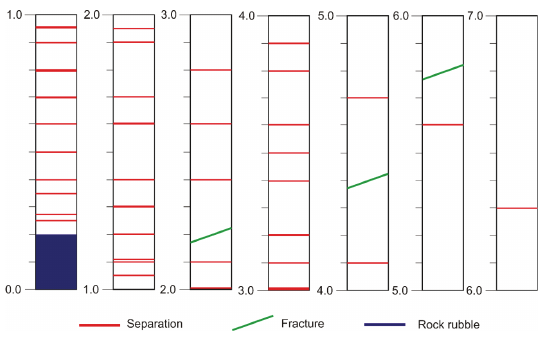
Fig. 4. Results of endoscope test in the roof of C-1 crosscut Figure 4: Results of endoscope test in the roof of C-1 cross-cut.